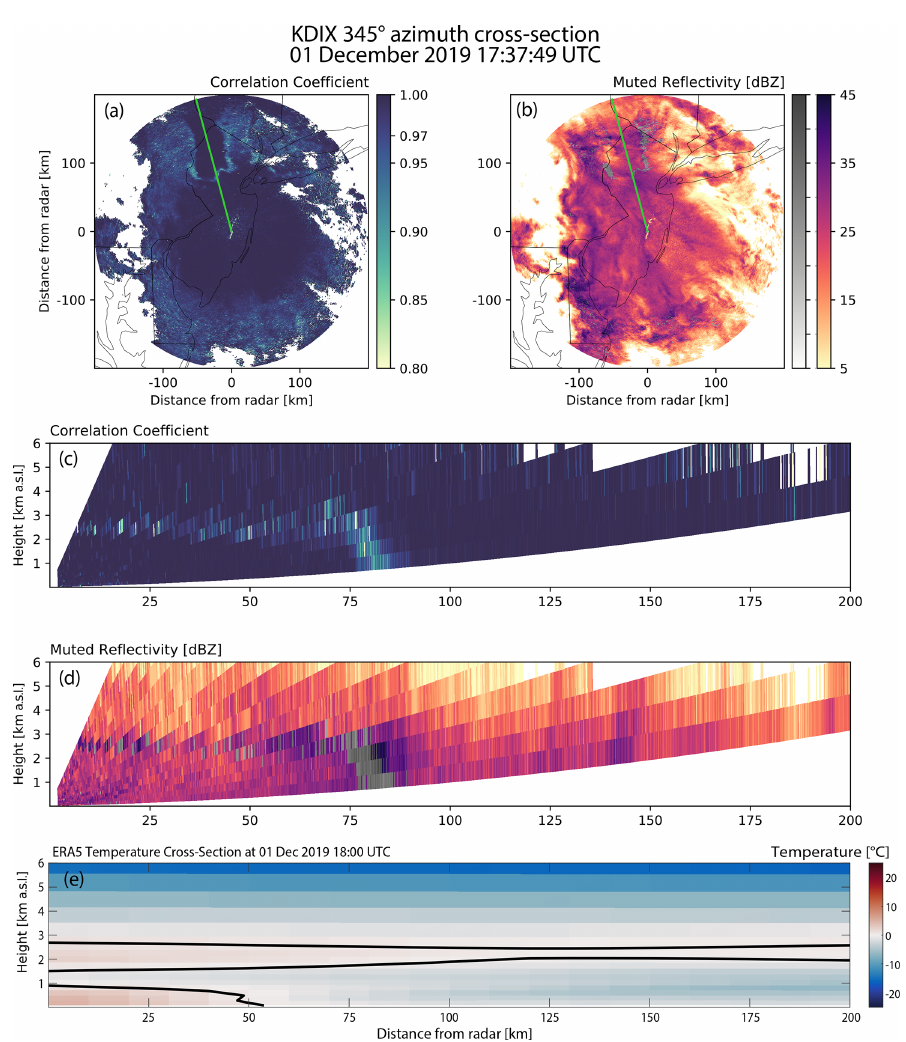
Figure 6. Comparison of image-muted regional map with reconstructed RHIs and reanalysis temperature vertical cross-section from the KDIX radar on 1 December 2019. (a) Correlation coefficient and (b) image- muted reflectivity (dBZ) 0.5 ◦ elevation angle PPI plots for the KDIX radar valid 1 December 2019 17:37:49UTC. Green line in panels (a) and (b) indicates the location of reconstructed RHI cross- sections from (c) the correlation coefficient and (d) image-muted reflectivity. (e) ERA5 reanalysis temperature cross-section interpolated to the plane of the RHI. Black line in panel (e) indicates 0 ◦ C isotherm. An animated version of this figure (Animation-Figure-6) is in the Video